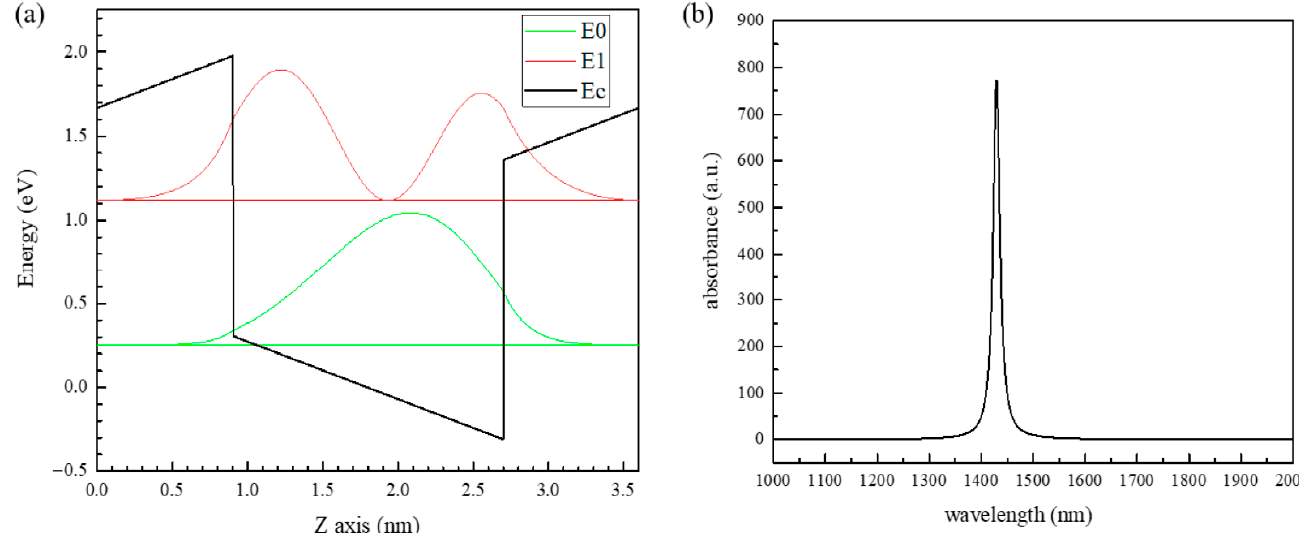
Figure 4. ( a ) Band position and carrier distribution of the one-period GaN/AlN (1.8 nm/1.8 nm) quantum well. The black line is the conduction band of the quantum well, the conduction band of AlN on both sides, and the conduction band of GaN in the middle. The green lines are the position of the ground state level E0 in the quantum well (straight line) and the distribution of carriers in the ground state (curved line). The red lines show the position of E1 in the first excited state in the quantum well (straight line) and the distribution of carriers in the first excited state (curved line). ( b ) The simulation results of absorption coefficient of infrared light in the range of 1000 to 2000 nm for the GaN/AlN (1.8 nm/1.8 nm) quantum well.